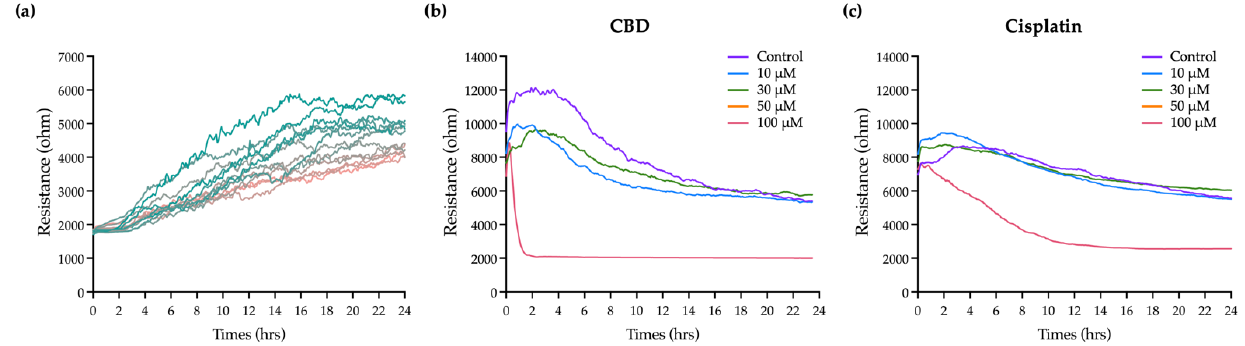
Figure 3. Effect of CBD and cisplatin on the integrity of the OEC-M1 cellular layer using the ECIS method: ( a ) The increased resistance time course curve shows the process for the formation of a an OEC-M1 cell monolayer. Each resistance curve is for each independent electrode containing wells. ( b ) CBD and ( c ) cisplatin were added into each ECIS well (at time 0) for 24 h of incubation. The change in resistance compared with the control group shows the integrity of the cell layer after the treatment with the drug. Each curve shows similar results for at least three independent experi- ments.